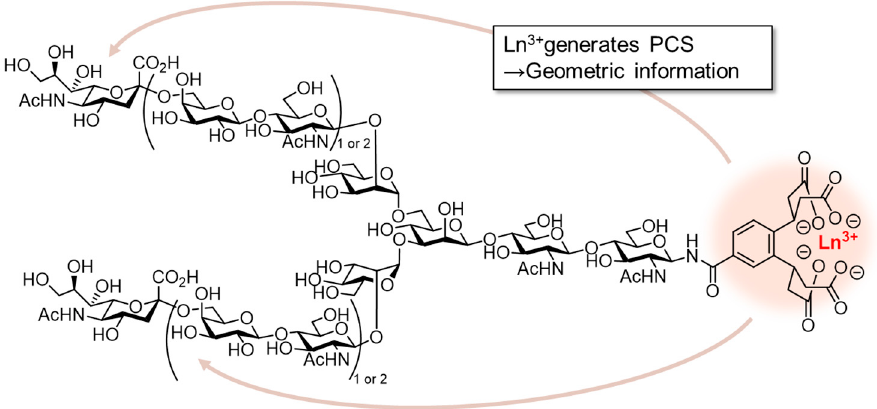
Figure 5. Conformation analysis of N -glycan using pseudocontact shift (PCS). Chelation with paramagnetic metals can induce PCS to give geometric information of N -glycan.